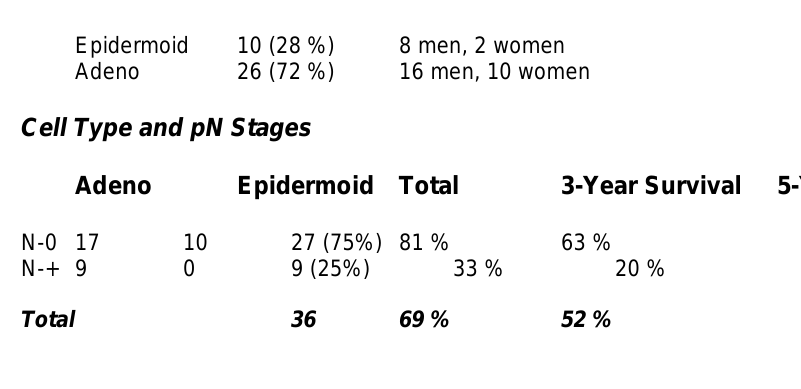
Cell Type and Postsurgical Stage of T1 Lung